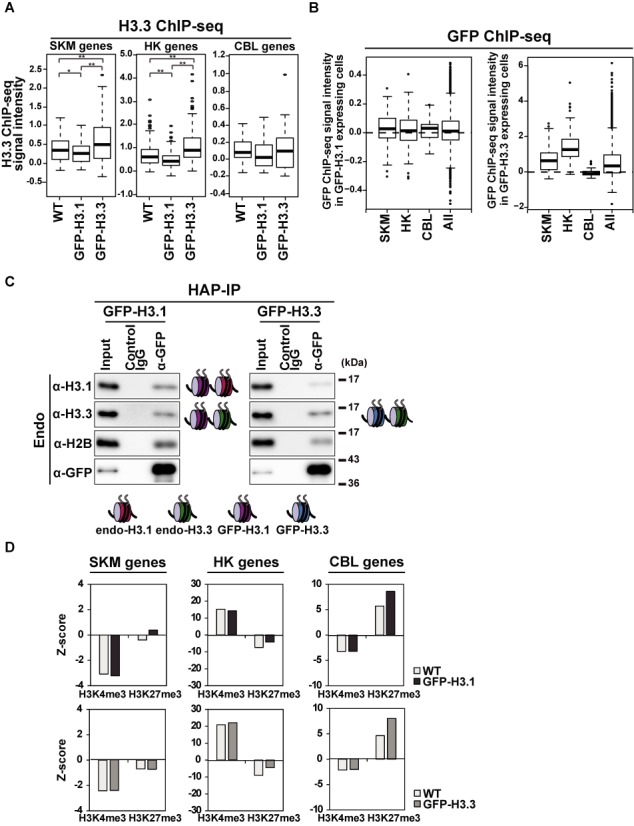
Global effects of GFP-H3.1 overexpression on endogenous H3.3 and modifications. (A) H3.3 enrichment in different gene sets. Box plots show H3.3 ChIP-seq signal intensities for the indicated gene sets at TSS ± 2 kb. Mann-Whitney test was used for the statistical analysis. *P < 0.05, **P < 0.01. Related data are shown in Supplementary Tables S4 and 5. (B) GFP-H3.1 or GFP-H3.3 incorporation in different gene sets expressed in box plots. GFP ChIP-seq signal intensities were analyzed at TSS ± 2 kb. Related data are shown in Supplementary Tables S4 and 5. (C) Co-localization of GFP-H3.1 and endogenous H3.3 in nucleosomes. Hydroxyapatite (HAP)-purified chromatin from C2C12 cells expressing GFP-H3.1 and GFP-H3.3 were immunoprecipitated with control IgG and GFP-specific antibody, and the presence of endogenous histones were analyzed by Western blotting. H3.3 was associated with GFP-H3.1-containing nucleosomes to form a bivariant state. (D) Association of H3K4me3 and H3K27m3 with different gene sets expressed as Z-scores from ChIP-seq signal intensities in each gene set at TSS ± 2 kb. GFP-H3.1 expression caused preferential H3K27me3 in SKM genes.